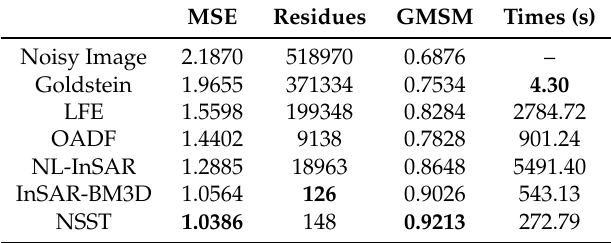
Table 6. Performance of various methods.